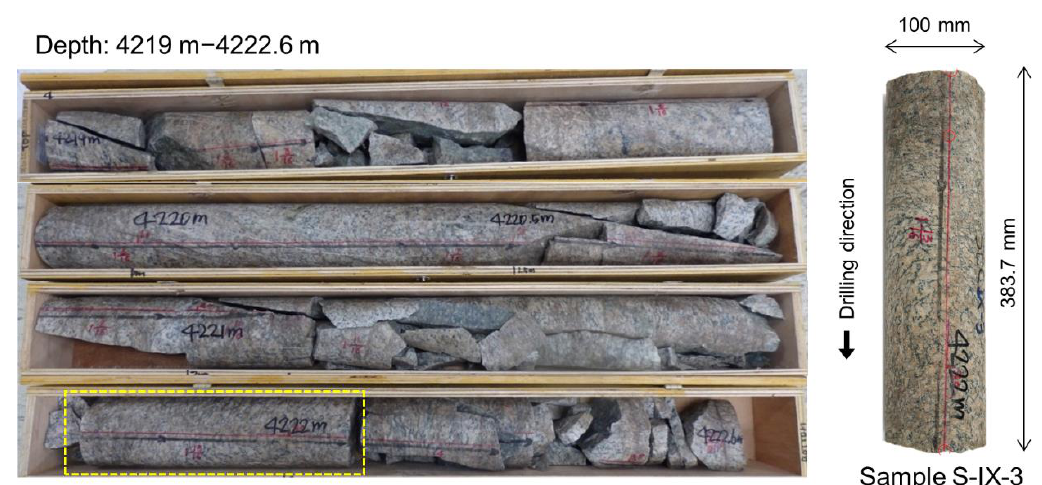
Figure 2. Rock samples extracted from a PX-2 well. The dashed rectangle indicates the studied core sample (S-IX-3) for stress estimation and roughness assessment of a closed joint.